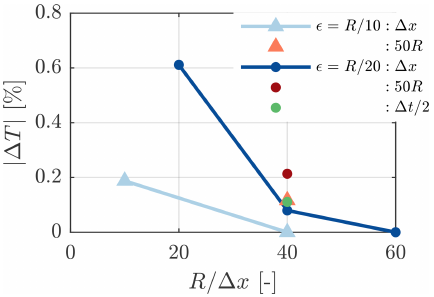
Figure 3. Thrust sensitivity of the NREL 5-MW AL simulations at a 8ms − 1 wind speed with respect to grid size, doubling the domain size and halving the time step at two smearing length scales ( N s = { 9 , 19 } , T = { 4 . 20 , 4 . 06 }× 10 5 ref